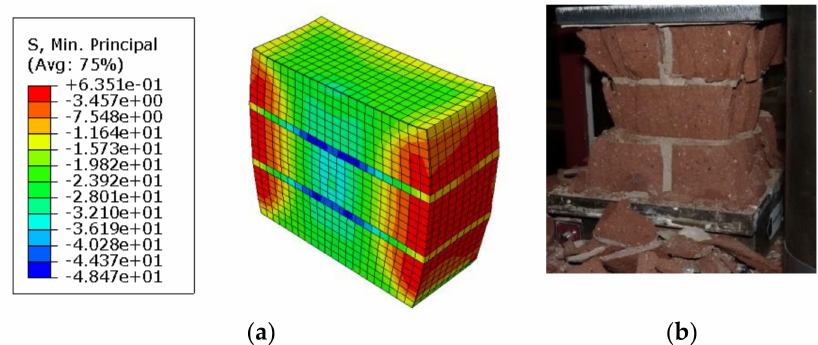
Figure 13. Numerical output forMC model( a ) vs. experimental observation ( b